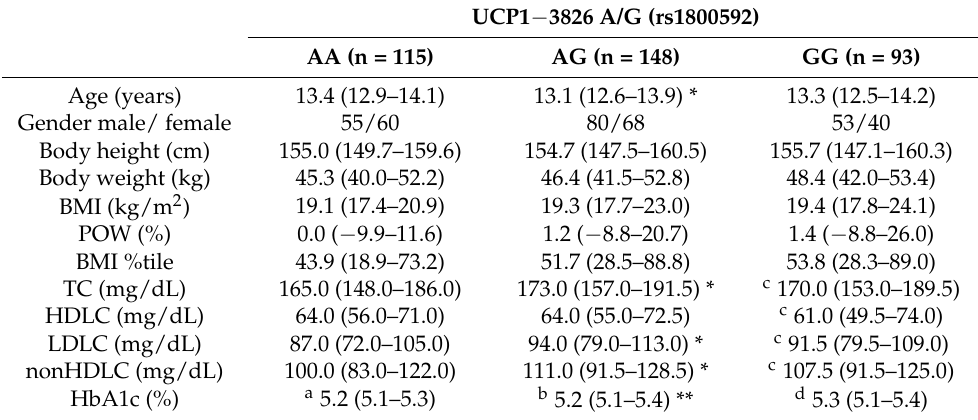
Table 5. Clinical characteristics of the UCP1-3826 A/G (rs1800592) SNP genotype.